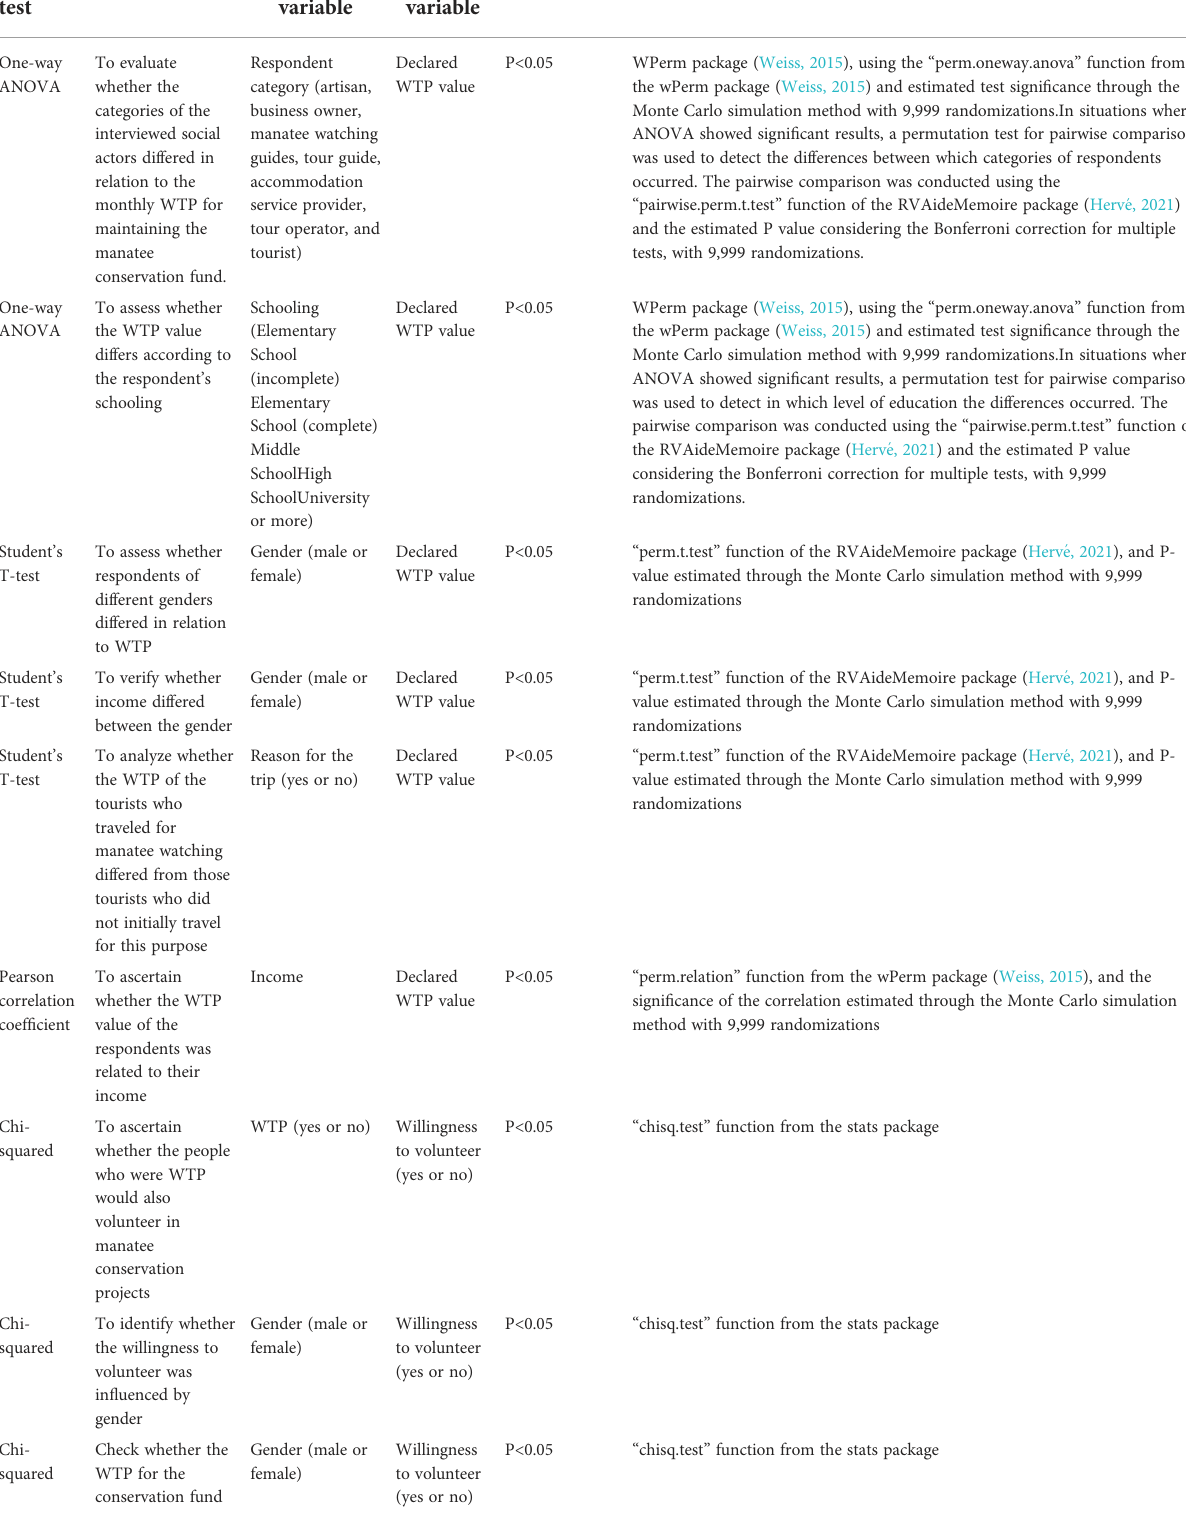
TABLE 1 Statistical analyses conducted in the